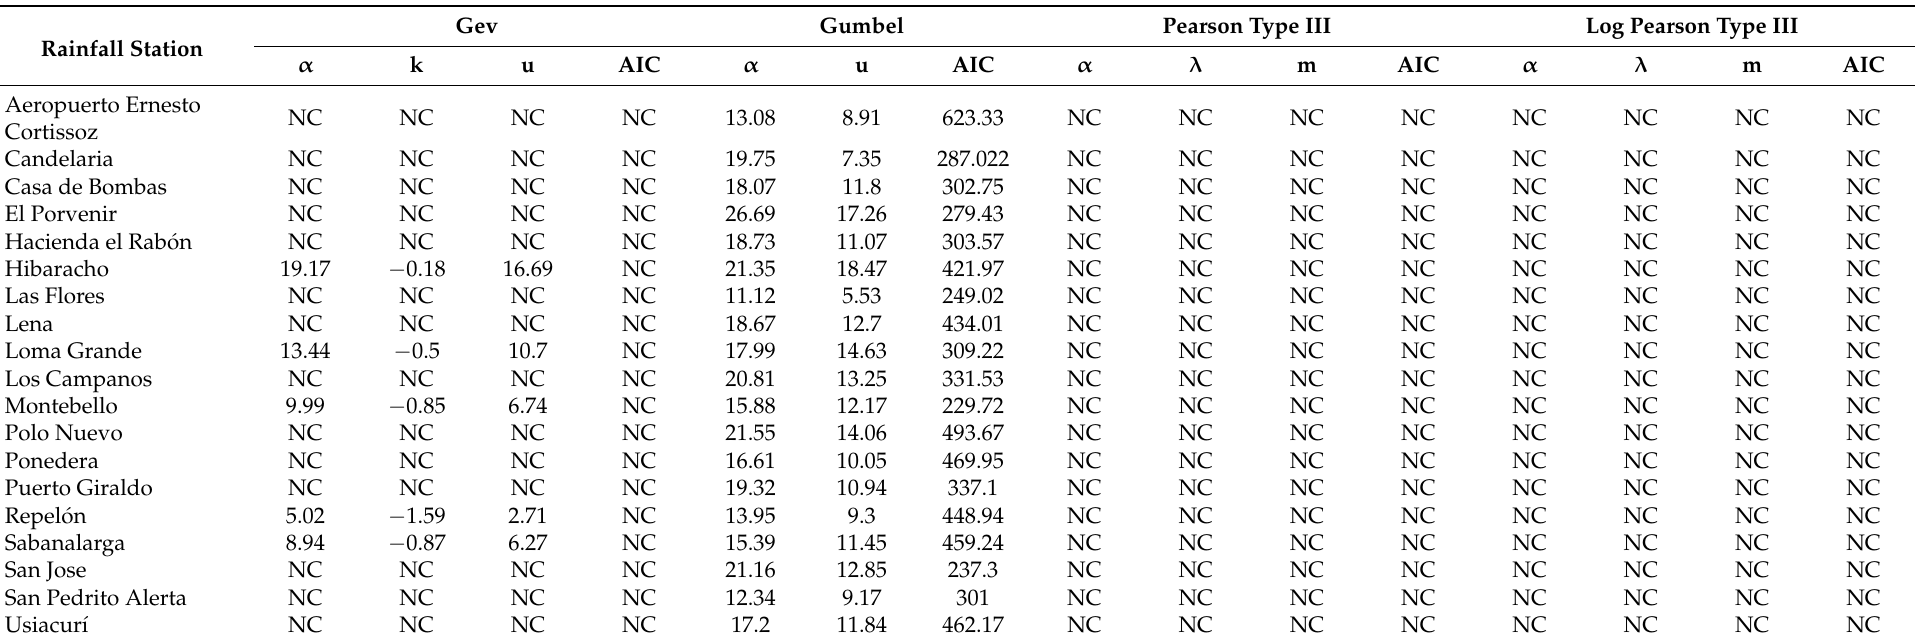
Table A3. Summary of parameters and AIC values of the different distribution functions using the maximum likelihood